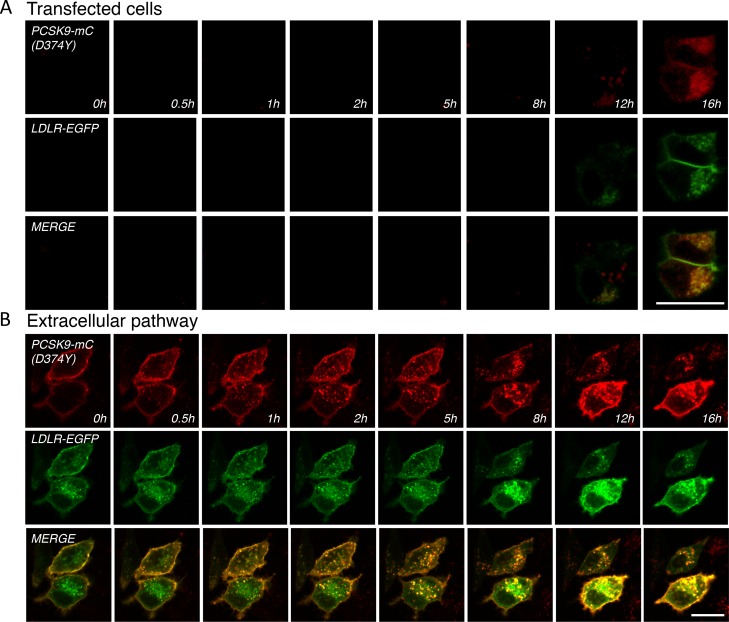
Live-cell imaging of PCSK9-D374Y-mC and LDLR-EGFP trafficking.HepG2 cells were transfected with LDLR-EGFP together with D374Y PCSK9-mC (A; transfected cells, see also S1 Video) or incubated with PCSK9 D374Y-mC conditioned media (B; extracellular pathway, see also S2 Video). Images were extracted from confocal microscopy time-lapse movies. Data are representative of at least three independent experiments. Scale bar, 20 μm.